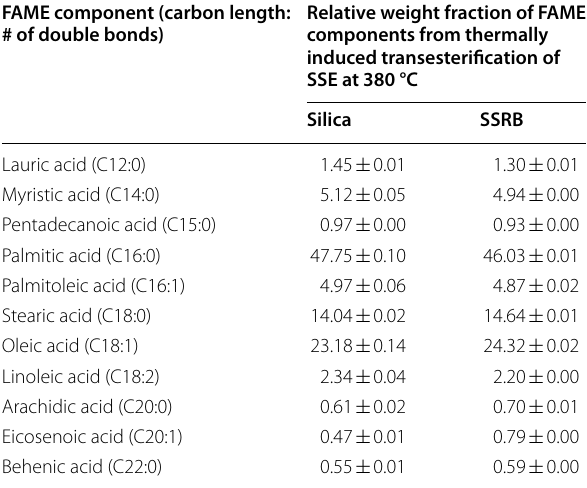
Table 2 FAME compositions obtained from thermally induced transesterification of SSE in the presence of silica and SSRB FAME component (carbon length: Relative weight fraction of FAME # of double bonds) components from